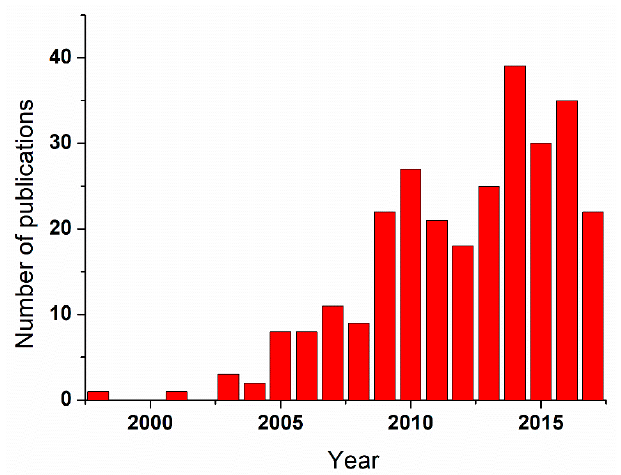
Figure 1 . Time evolution of the number of published works within the field of cell scaffolds combined with Atomic Force Microscopy.